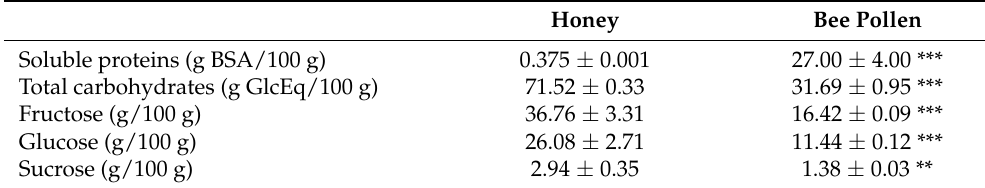
Table 5. Soluble proteins, total carbohydrates, and individual sugars content of honey and bee pollen. Honey Bee Pollen Soluble proteins (g BSA/100 g) 0.375 ± 0.001 27.00 ± 4.00 *** Total carbohydrates (g GlcEq/100 g) 71.52 ± 0.33 31.69 ± 0.95 *** Fructose (g/100 g) 36.76 ± 3.31 16.42 ± 0.09 *** Glucose (g/100 g) 26.08 ± 2.71 11.44 ± 0.12 *** Sucrose (g/100 g) 2.94 ± 0.35 1.38 ± 0.03 ** Values are expressed as mean ± SD. *** p < 0.001, ** p < 0.01 vs. Honey